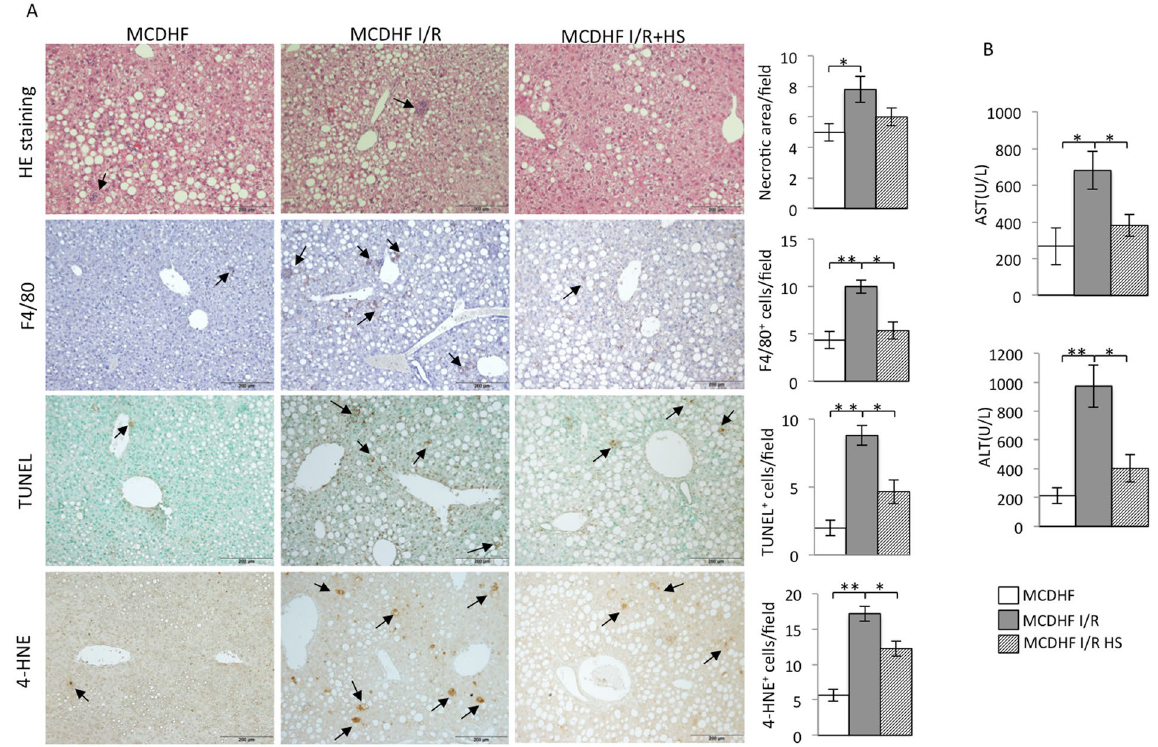
Figure 1. Hydrogen saline attenuated necrosis, infiltration of macrophages, oxidant stress, and apoptosis as well as the biochemical parameters related to I/R injury in the steatotic liver. ( A ) The necrotic area (first line) of the MCDHF diet group (left panel), I/R group (middle panel), and hydrogen saline treatment group (right panel), TUNEL-positive cells (arrows, second line), F4/80-positive cells (arrows, third line), and 4-HNE-positive cells (arrows, fourth line). Scale bars represent 200 μ m. ( B ) The number of necrotic areas, TUNEL-positive cells, F4/80-positive cells, and 4-HNE-positive cells and the serum ALT and AST levels after 15 minutes ischemia and 3 hours reperfusion. Data are expressed as the means ± SEM; * p < 0.05, ** p <